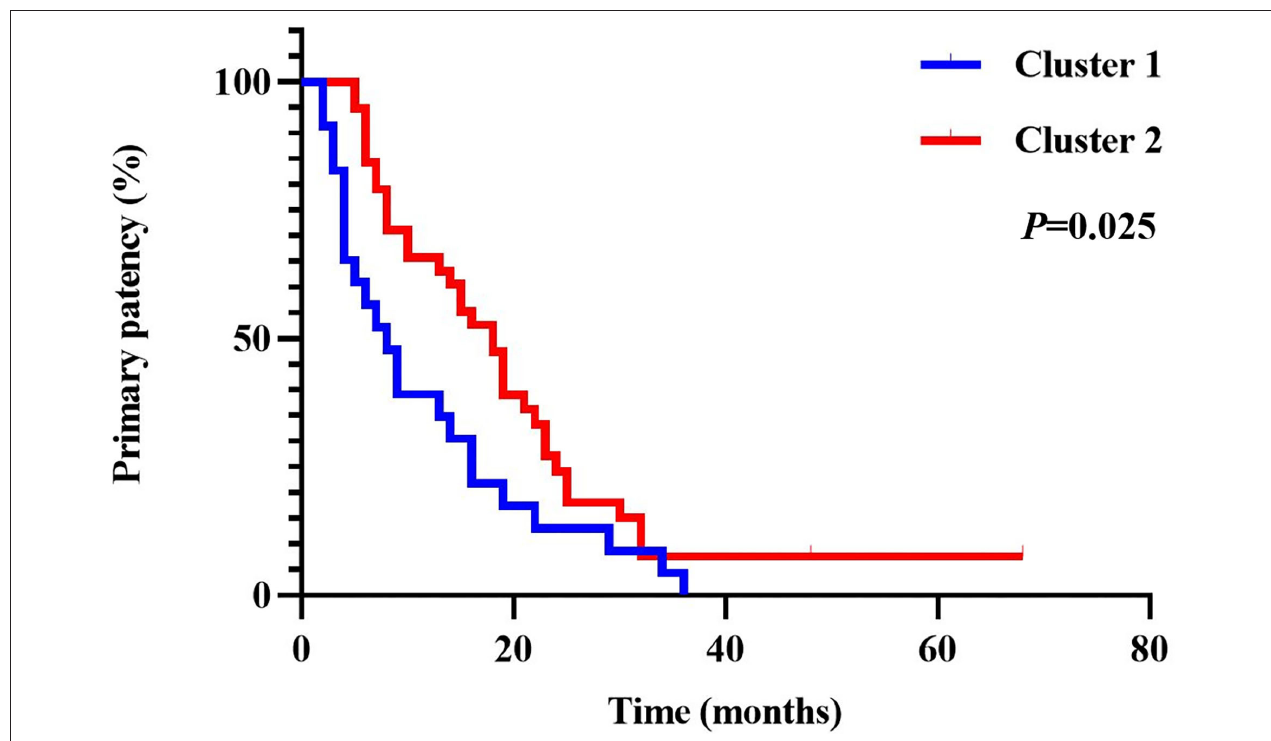
FIGURE 7 | Cumulative primary patency rates between the two